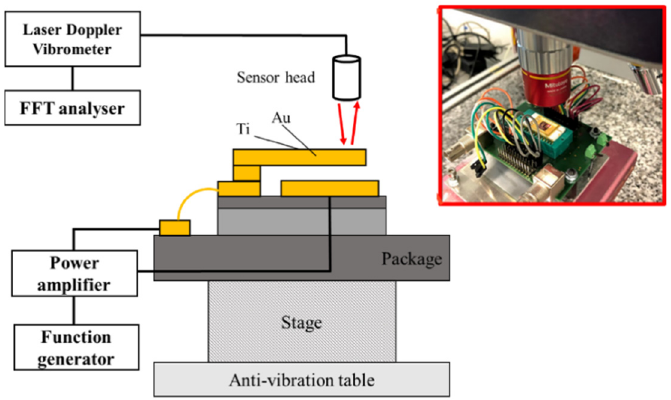
Figure 3. Resonance frequency measurement system.